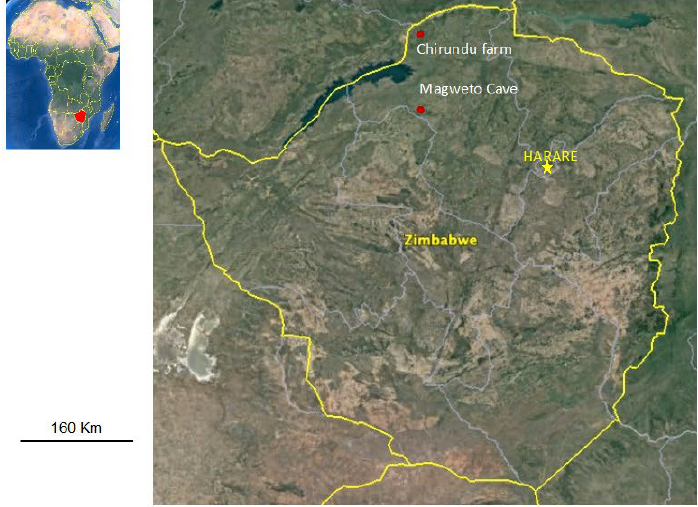
Figure 1. The study sites highlighted on the map show the sampling areas for insectivorous bat colonies in Hurungwe district.